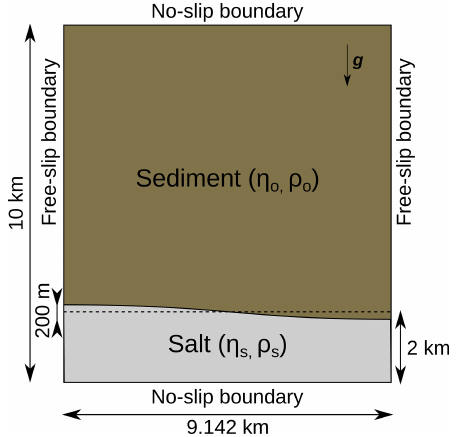
Figure 4. Setup of the model scaled up from van Keken et al.